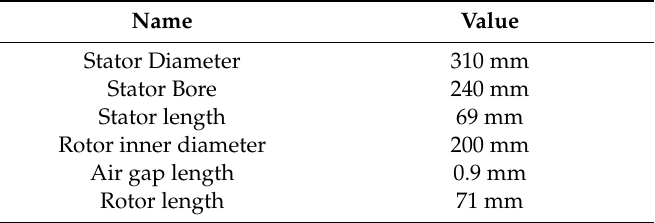
Figure 1. The detailed structure of the in-wheel motor (IWM). Table 1. Structural parameters of the in-wheel motor (IWM).